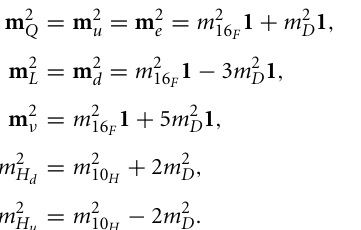
(cid:4)(cid:5) (cid:5) (cid:3) (cid:2) (cid:5) m 2 (cid:5) . The values for the other model = sign ( m 2 m 2 ) D D D